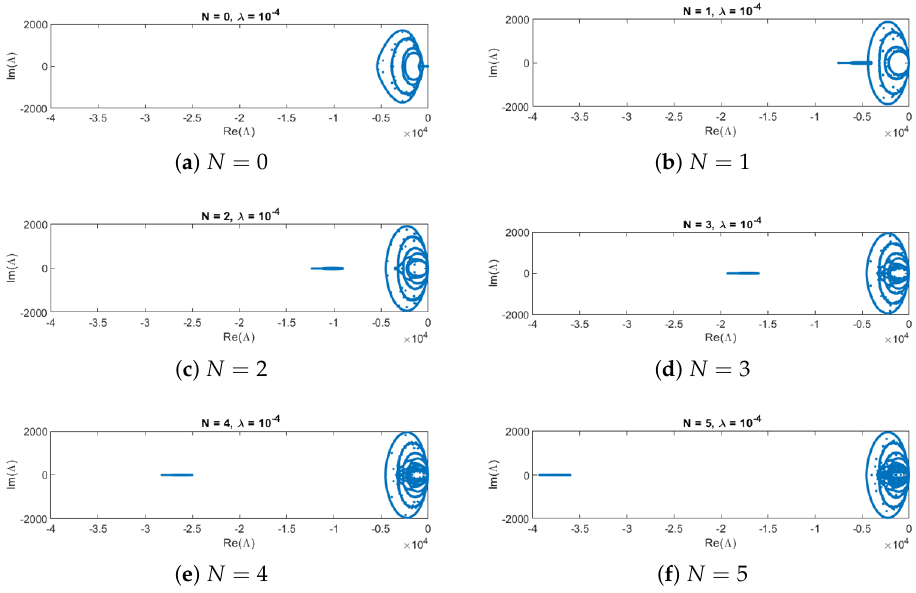
Figure 3. Eigenvalue spectrum with increasing spectral gap for dam-break case with varying N and fixed ν = 0.1, λ = 10 − 4 .